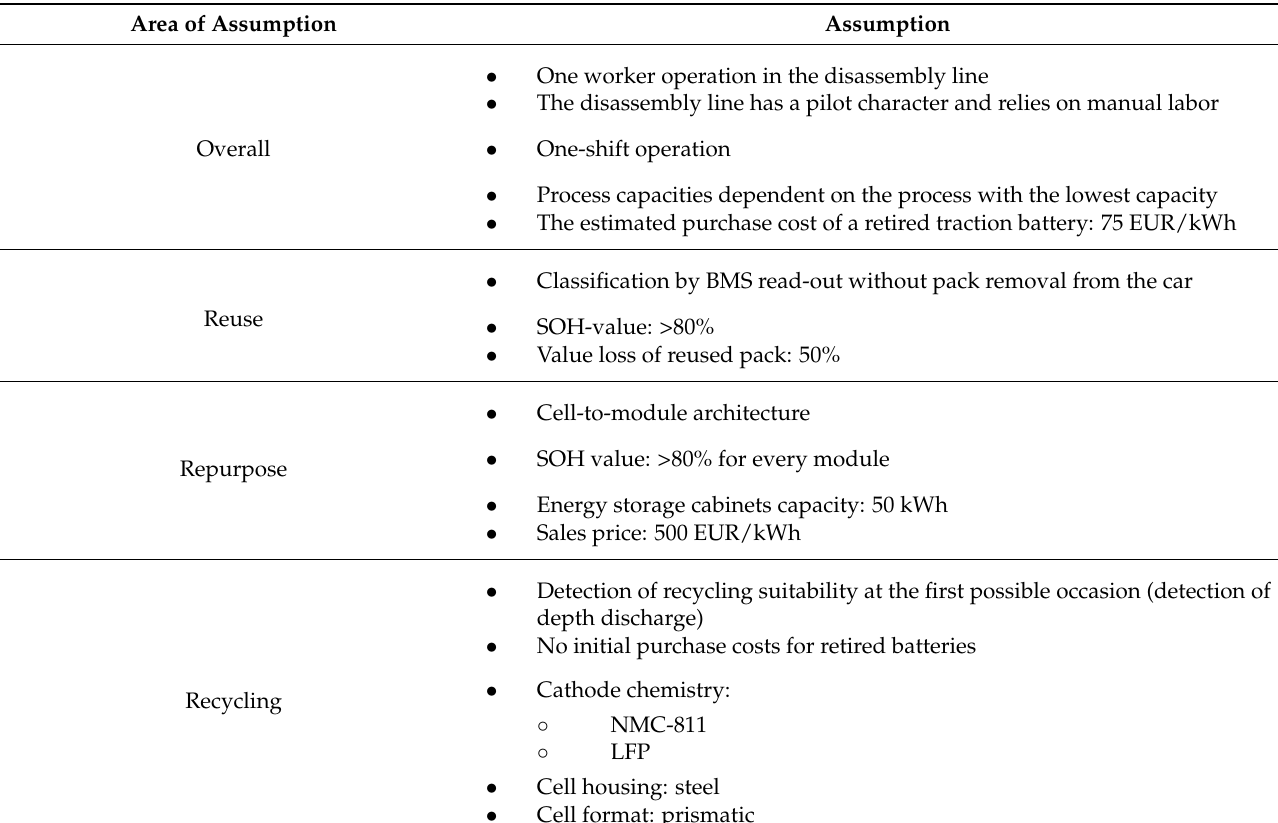
Table 2. General assumptions for the standard cost base